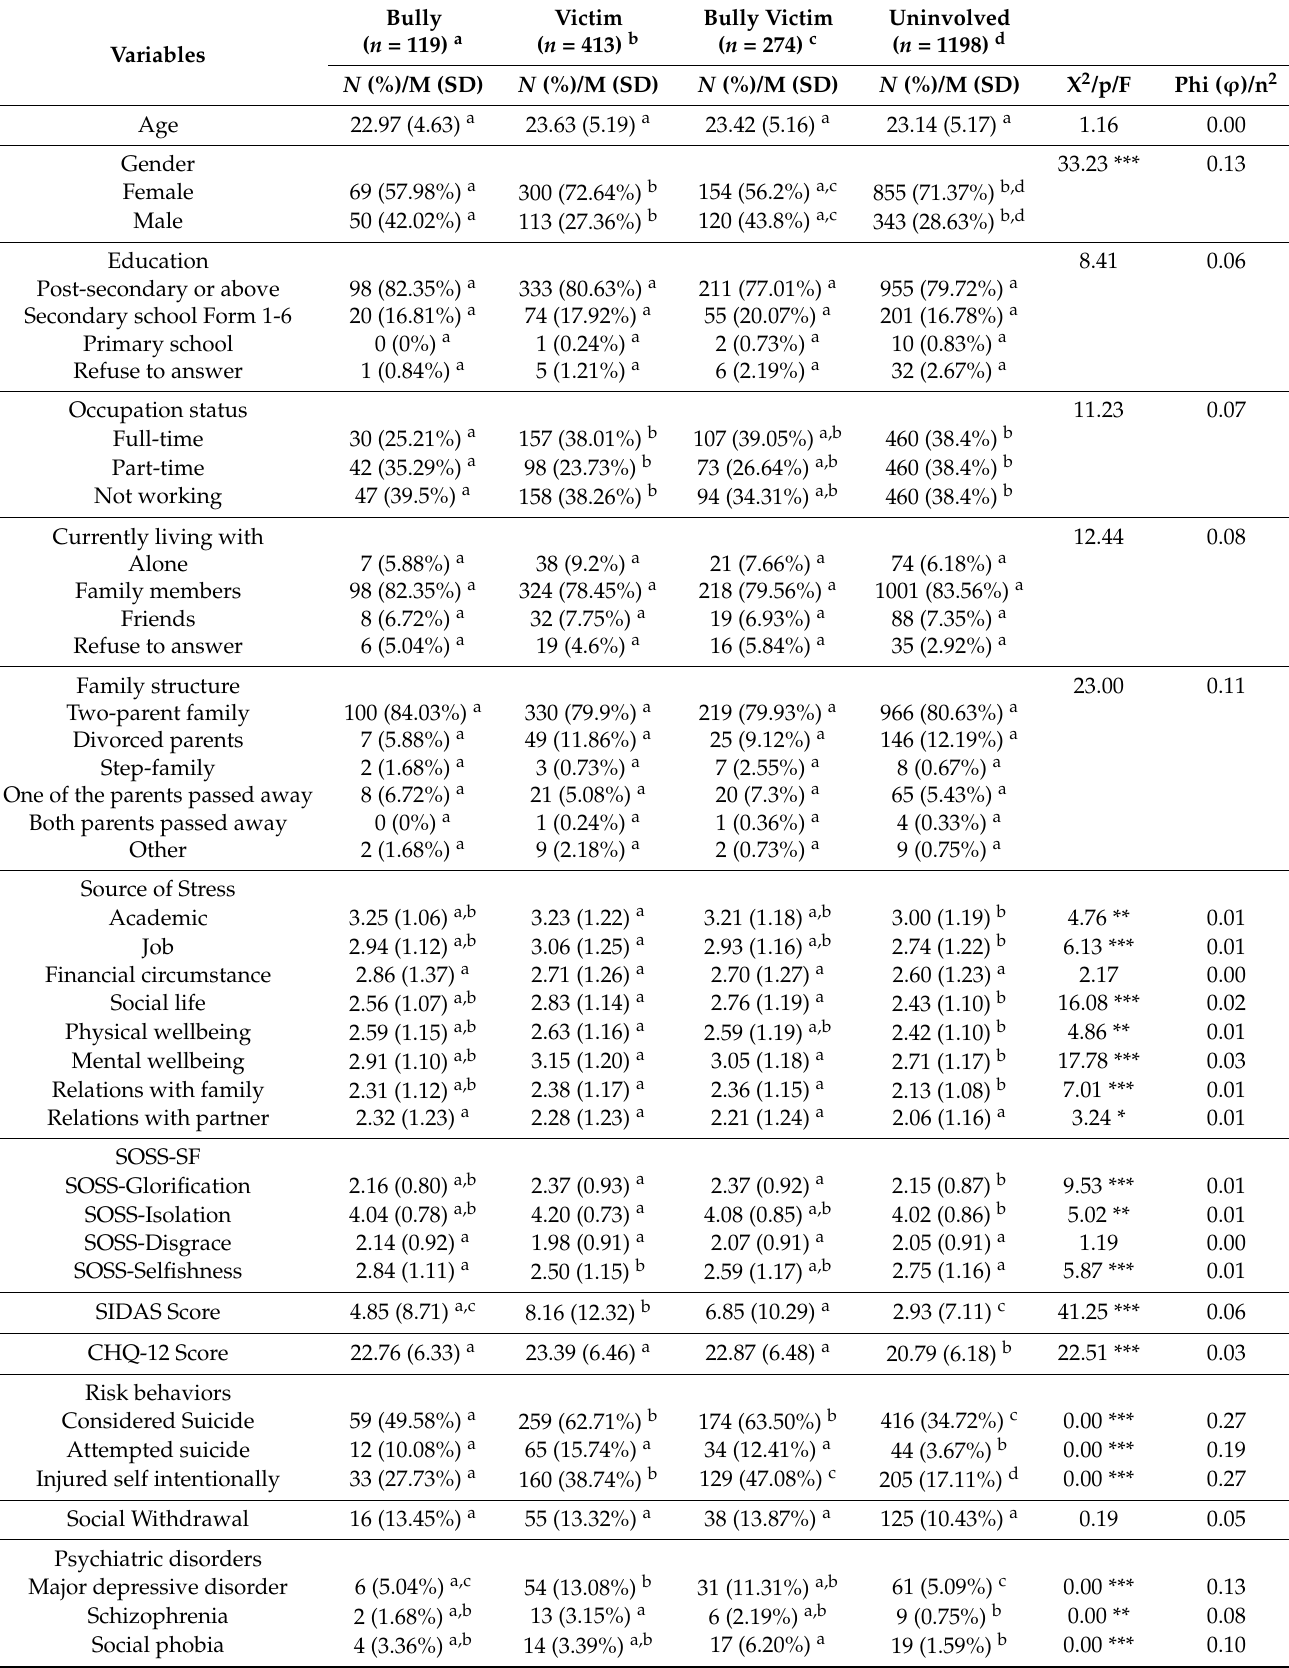
Table 1. Comparisons between the bully, victim, bully-victim, and uninvolved